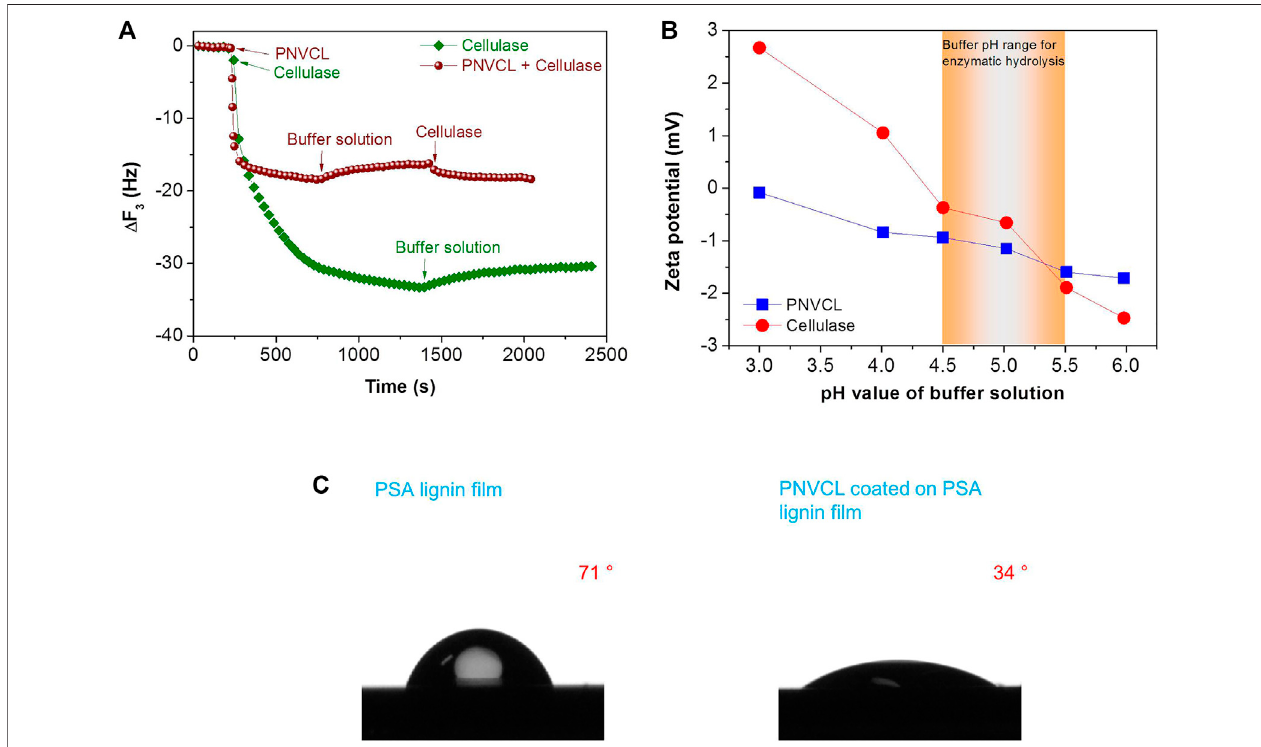
FIGURE6|(A) TheadsorptionofPNVCLandcellulaseonthePSAlignin fi lmduringQCMmeasurements; (B) zetapotentialsofPNVCLandcellulaseatdifferentpH values; (C) contact angles ofwater on the PSAlignin and PNVCL fi lms. The PNVCL solution was directly coated on the PSAlignin fi lm thatwaspre-coated on thesilicon wafer by a spin-coating method.